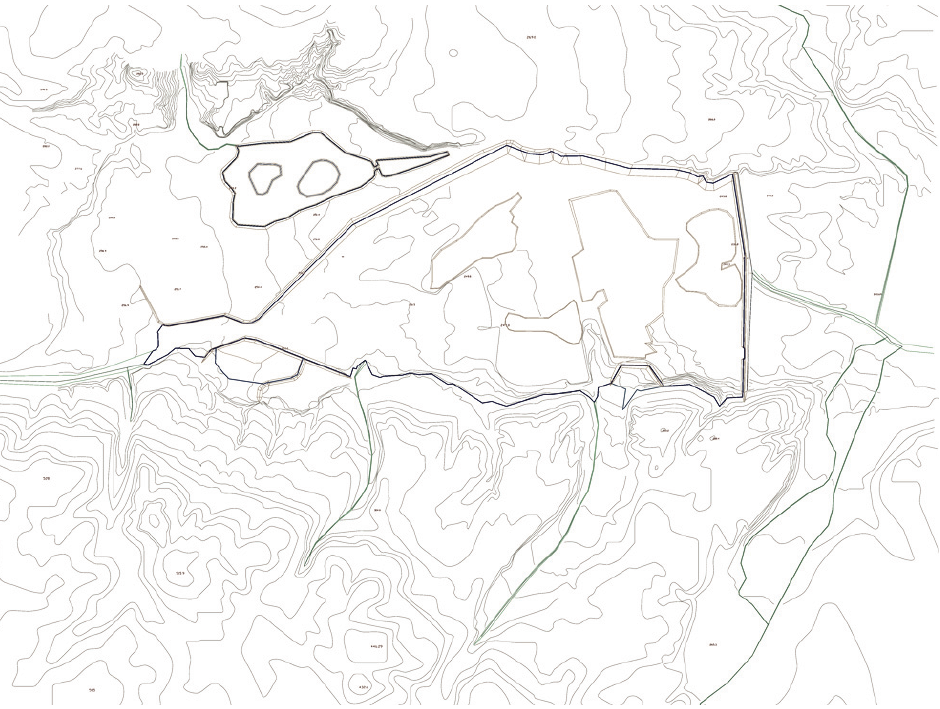
Fig. 5. Top view of a three-dimensional topographic map of the area in MicroStation